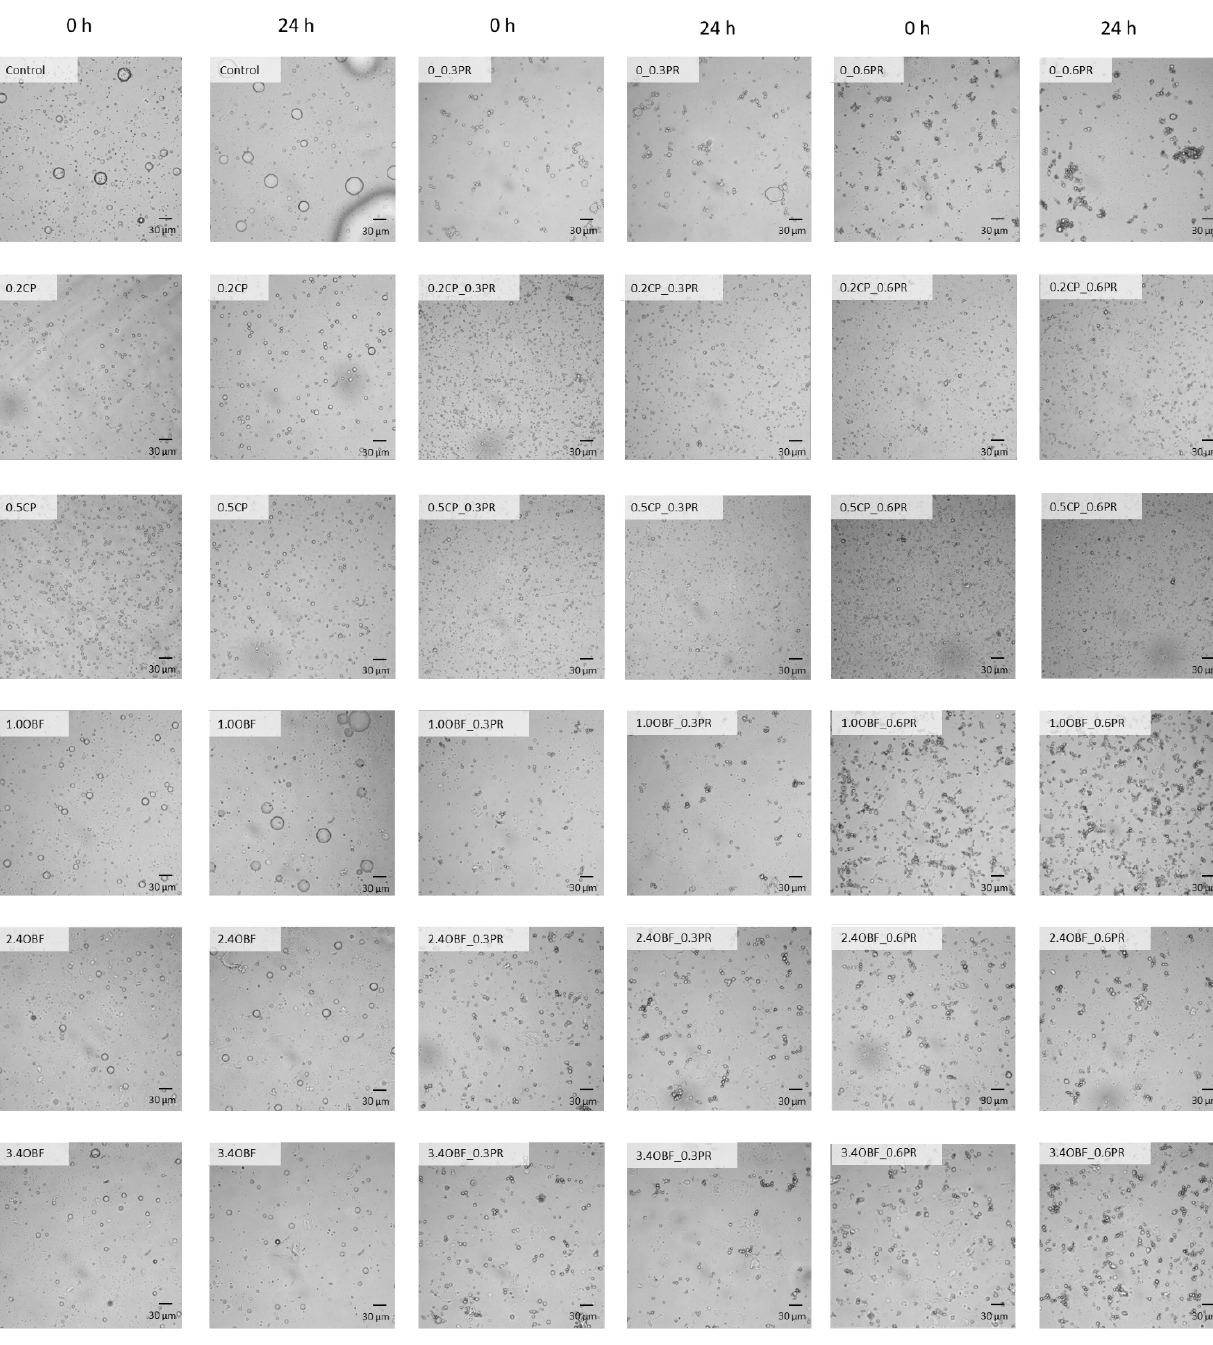
Figure 4. Micrographs of oil-in-water emulsions obtained with the optical microscope immediately after their preparation (0 h) or after 24 h, without any source of pectins or proteins (control), containing purified commercial pectins (0.2CP and 0.5CP for 0.2 and 0.5% w / w , respectively) or an orange by-product flour (1.0OBF, 2.4OBF, and 3.4OBF for 0.95, 2.38, and 3.40% w / w , respectively) combined with proteins (0.3PR and 0.6PR for 0.3 and 0.6% w / w , respectively) or without them (0PR).